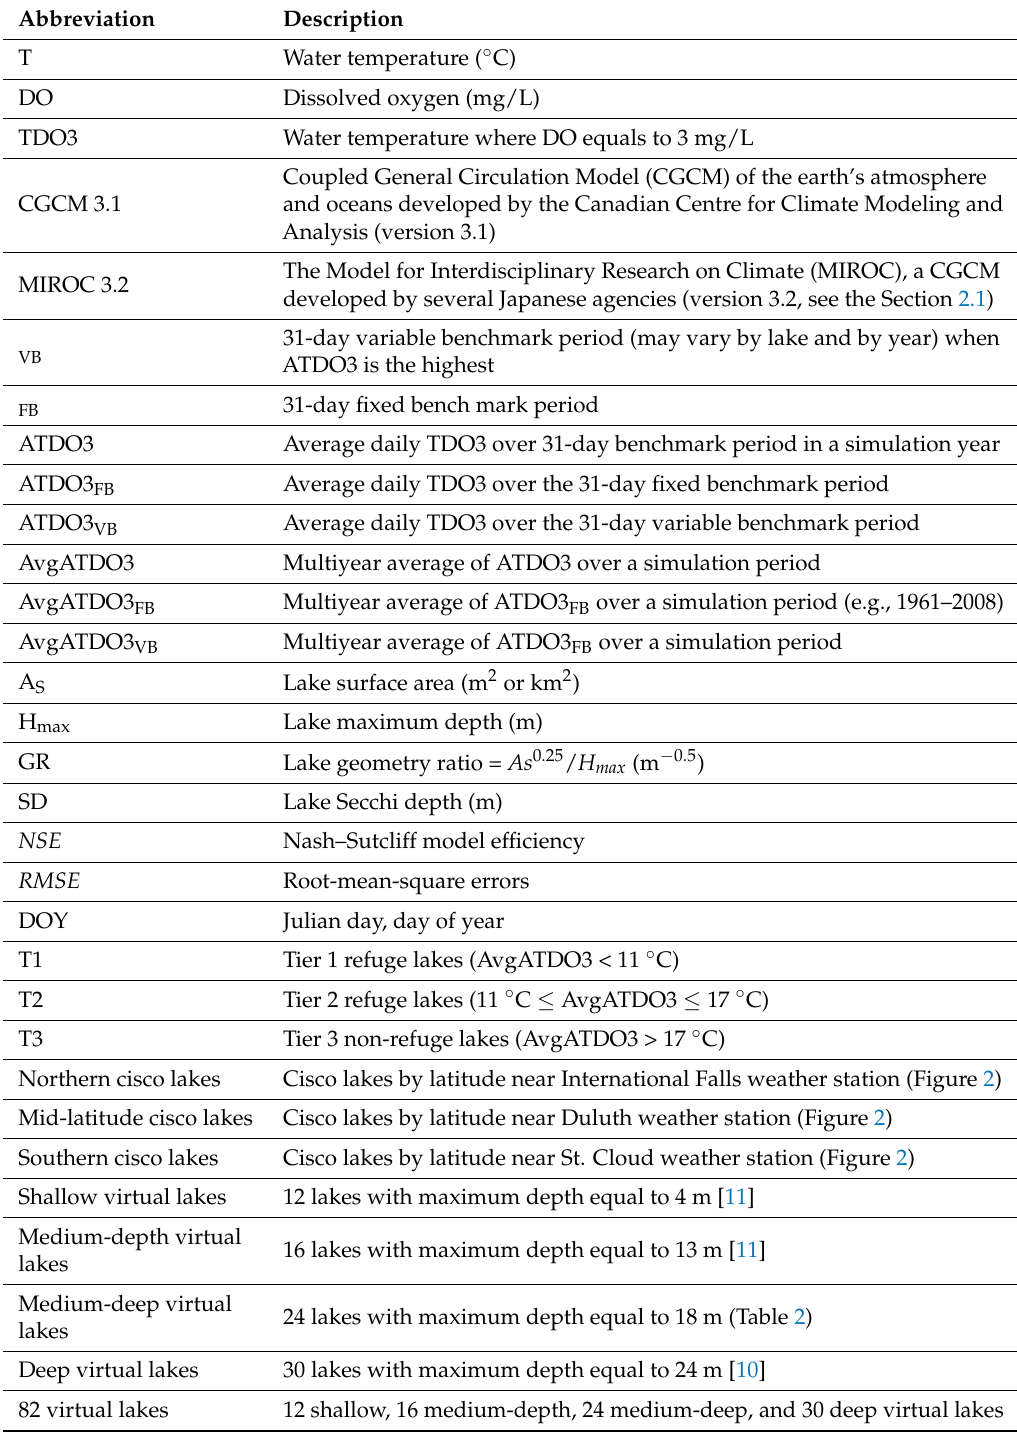
Table 1. Abbreviations of symbols and terms used in the